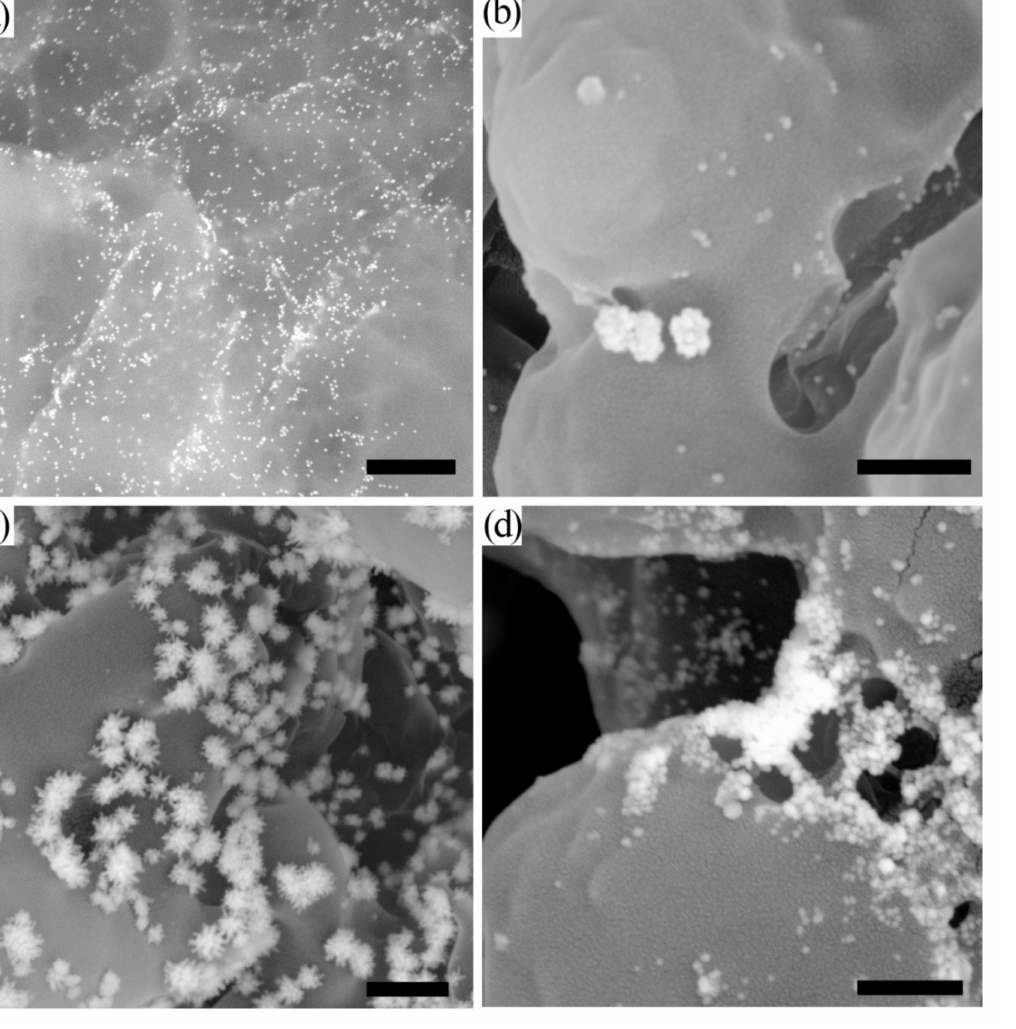
Figure 1. Microphotographs of nanoparticles in nitrocellulose membranes. ( a ) Au NPs; ( b ) Au@Ag NPs after silver enhancement; ( c ) Au@Ag-Au NPs after galvanic-assisted Au deposition; ( d ) Au NPs after gold enhancement. The bare scale is equal to 500 nm. Microphotographs were obtained using SEM operating in back-scattered electron detection